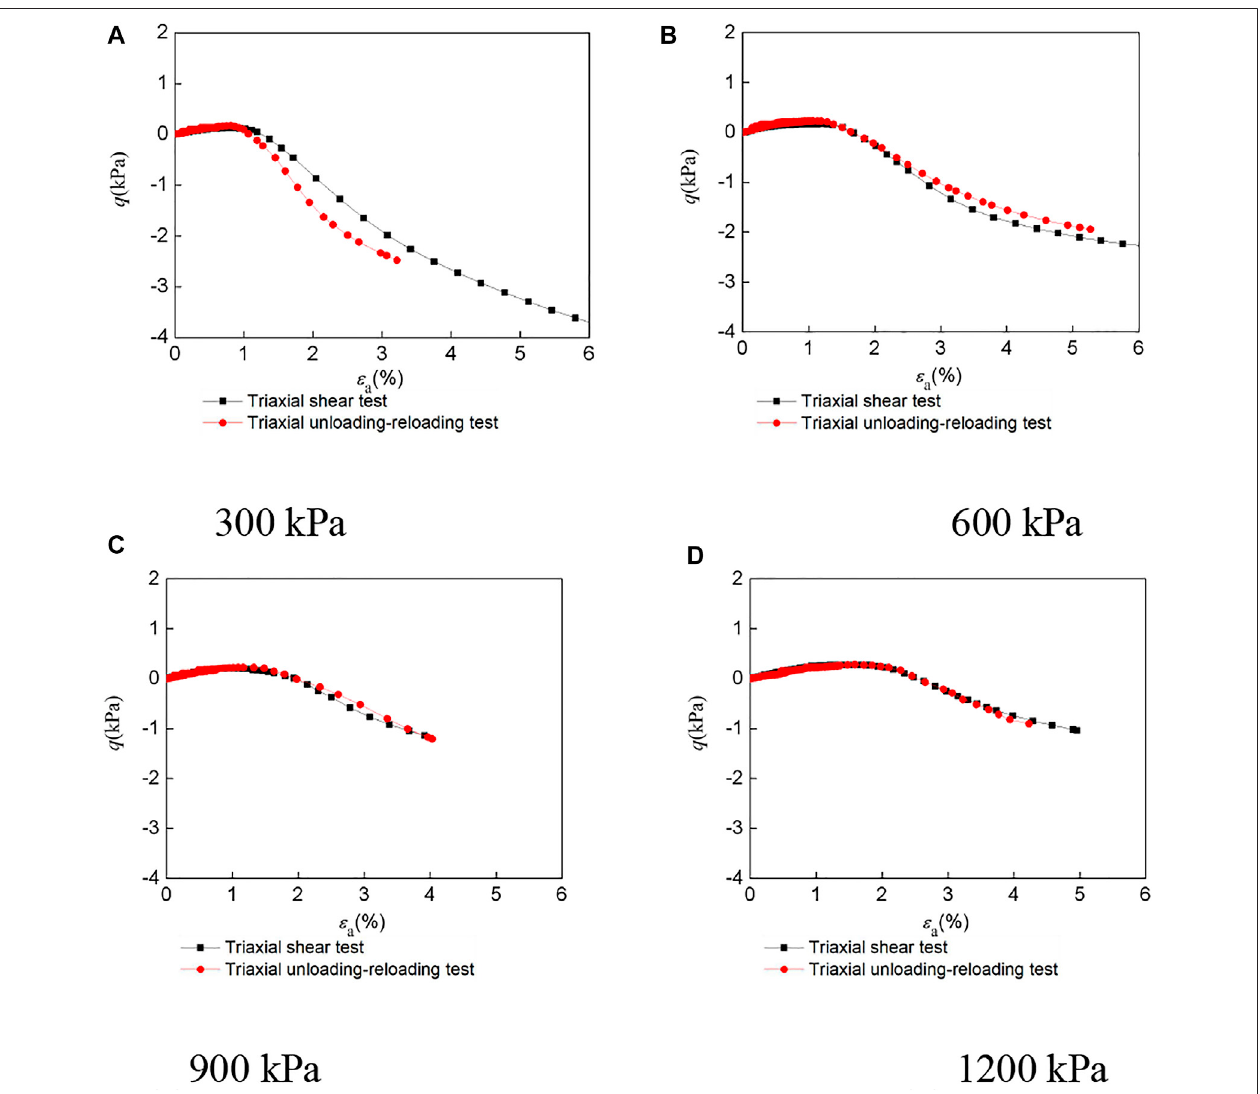
FIGURE 7 | Volumetric strain – axial strain curves of LCSG material with cemented content of 100 kg/m 3 under different con fi ning pressures. (A) 300 kPa (B) 600 kPa (C) 900 kPa (D) 1,200 kPa.